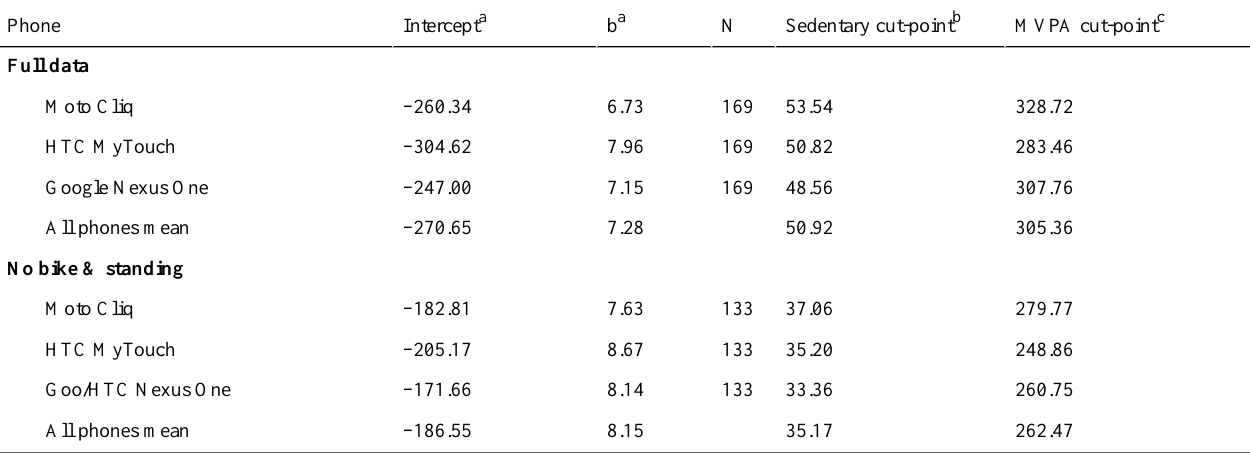
Table 2. Regression equations and cut-points for sedentary and moderate-to-vigorous levels of physical activity in the